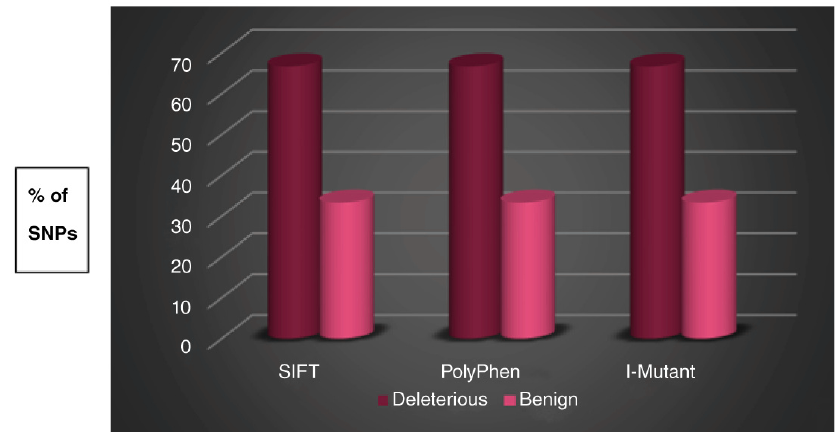
Figure 2. Distribution of deleterious and benign non-synonymous single nucleotide polymorphisms (nsSNPs) by Sorting Intolerant From Tolerant (SIFT), Polymorphism Phenotyping v2 (PolyPhen), and I-Mutant Suite. The magenta cylindrical bar indicates the percentage of nsSNPs that were found to be deleterious by SIFT, damaging (Possibly/Probably) by PolyPhen, and largely unstable by I-Mutant Suite. The pink cylinder indicates the percentage of nsSNPs that were found to be tolerated by SIFT, benign by PolyPhen, and largely stable/neutral by I-Mutant Suite.